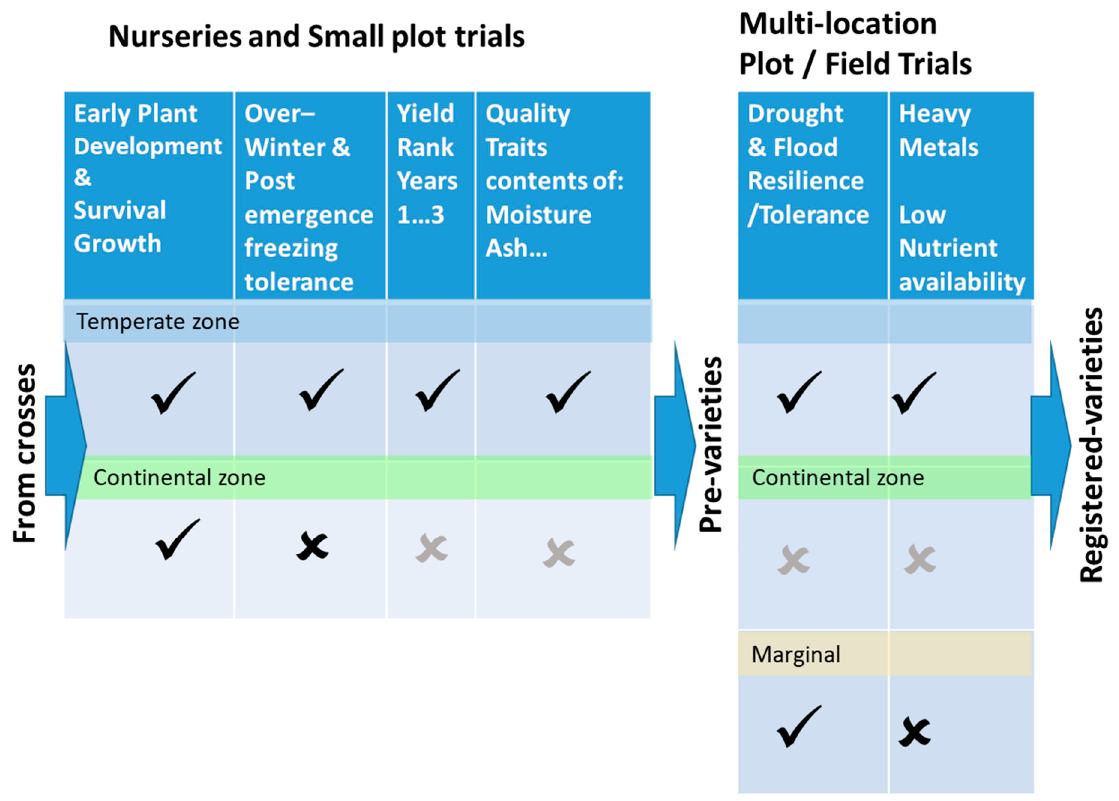
Figure 5. A schematic showing the different phases of selection applied to the progeny of crosses from successful transplantation, sufficient first season growth to overwinter through to the production of biomass yields above 10 t by the end of the second year with low ash and moisture content. Once a fail (an ‘ X ’) occurs in the selection sequence, the hybrid is eliminated. The extra steps indicated for pre-varieties illustrates further resilience testing related to likely stresses encountered on marginal lands. The resilience tests include tolerance to flooding, drought, low nutrients and heavy metal contaminants in the soil and apply to both potential parents and progeny.